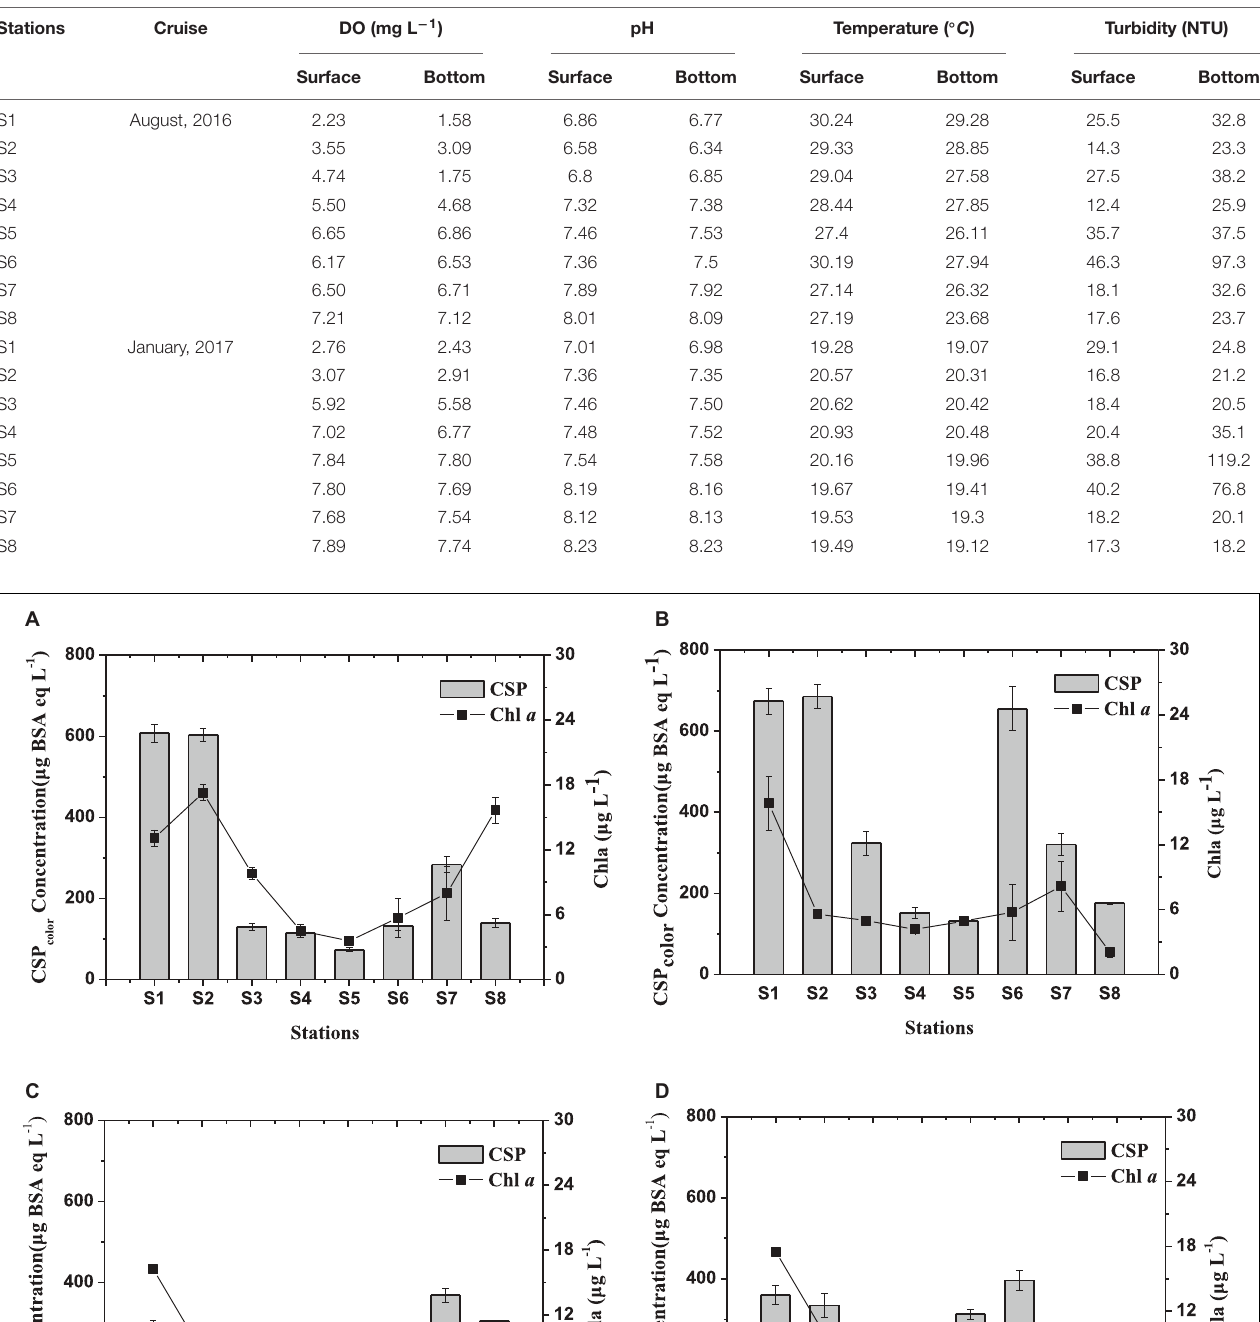
TABLE 1 | Environmental factors in the Pearl River estuary during August 2016 and January 2017 cruise. Stations